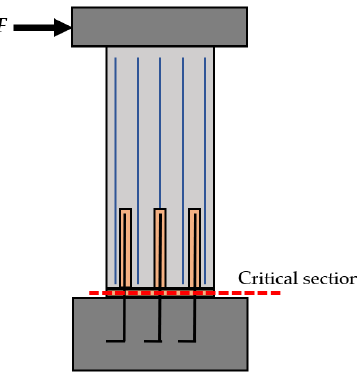
Figure 6. Potential critical cross-section of rectangular lightly reinforced precast walls.